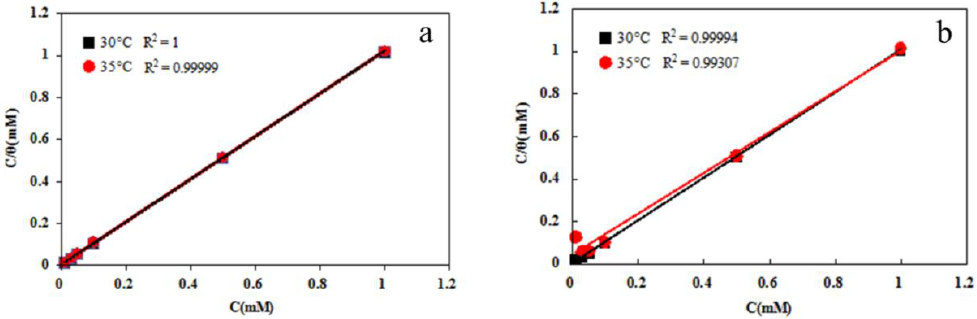
Figure 7. Langmuir isotherm adsorption isotherm of ( a ) DAN and ( b ) DBN in 1 M HCl solution.